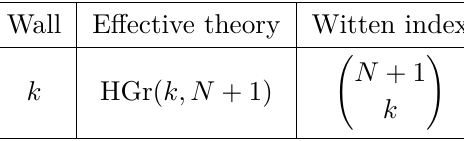
Table 1 . Domain wall solutions found for 4d N = 1 Sp( N ) SQCD with F = N + 1 flavors in the regime when m Λ . For each k -wall sector are included also the various contributions to the 4 d (cid:28) Witten Index of the low energy theory on the domain wall from each